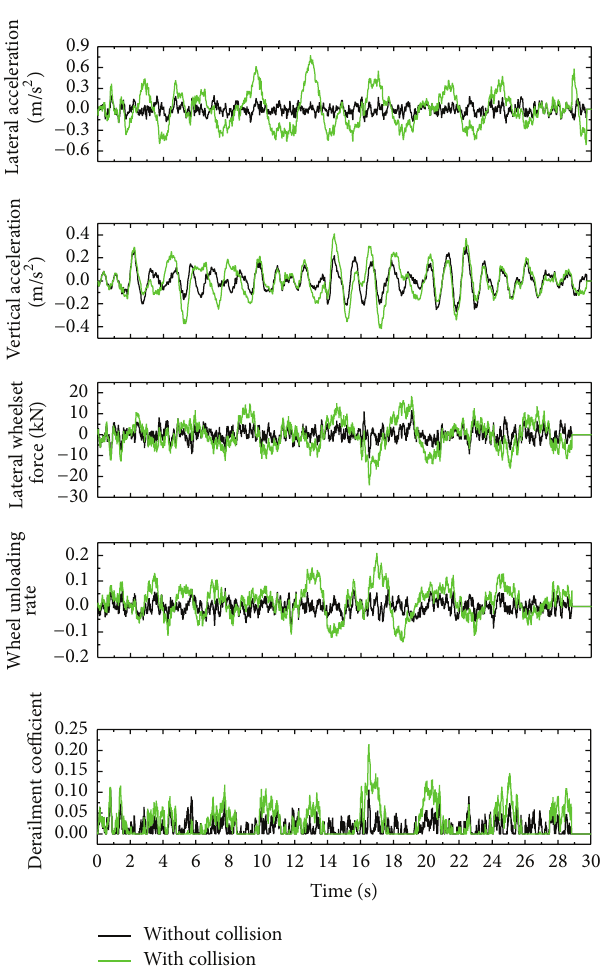
Figure 14: Responses of the motor car (the sixth train, 𝑋 2 = − 195 m, 80 km/h, in the up direction).